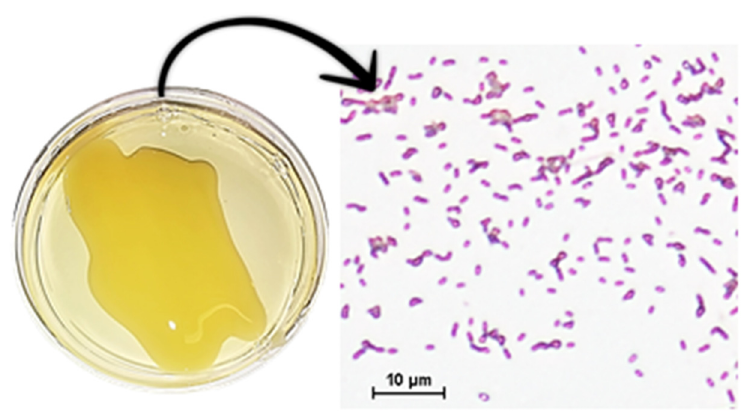
Figure 1. Xanthomonas campestris pv. campestris grown in potato dextrose agar (PDA) medium and an observation of the plate by a light microscope (Nikon eclipse E2000, Nikon ® Instruments Inc., Melville, NY, USA) with 100 × magnification, after Gram staining.